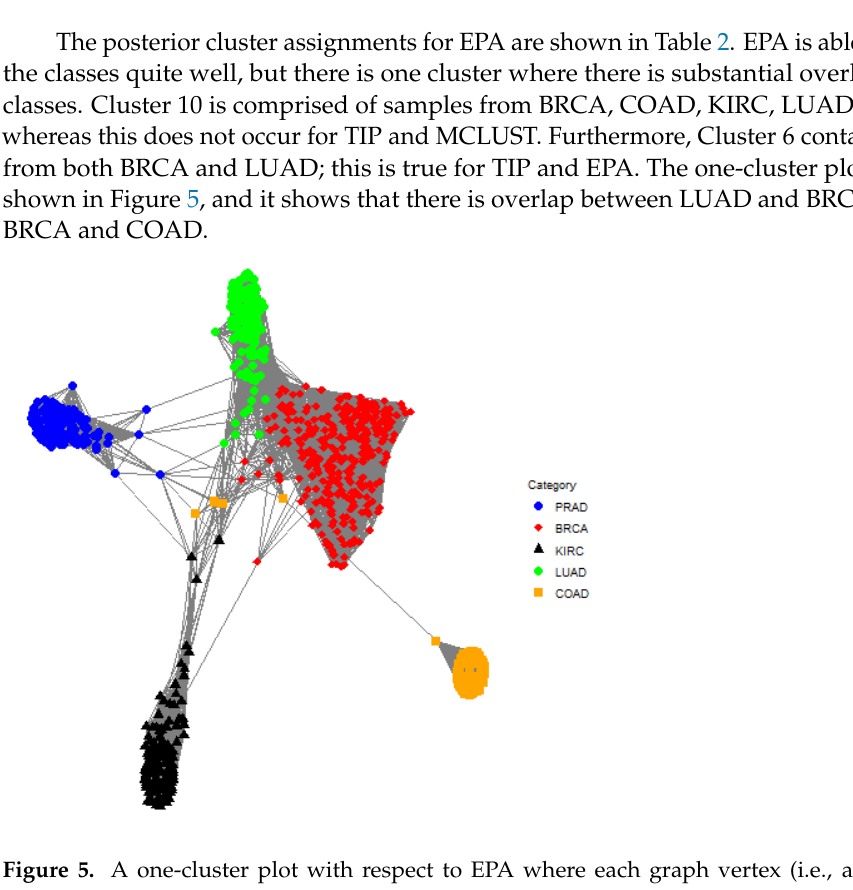
Figure 5. A one-cluster plot with respect to EPA where each graph vertex (i.e., a colored dot) corresponds to a subject (e.g., an individual gene expression sample) and the edge weights (i.e., the lines) correspond to the elements in the matrix ¯ B 1 . Specifically, the edge between subject i and subject j is the posterior probability that subject i and subject j are in the same cluster. Shorter lines correspond to larger posterior probabilities, so pairs of graph vertices that are closer to each other in the plot are more likely to be assigned to the same cluster. There is an overlap between LUAD (green circle) and BRCA (red diamond) as well as BRCA (red diamond) and COAD (orange